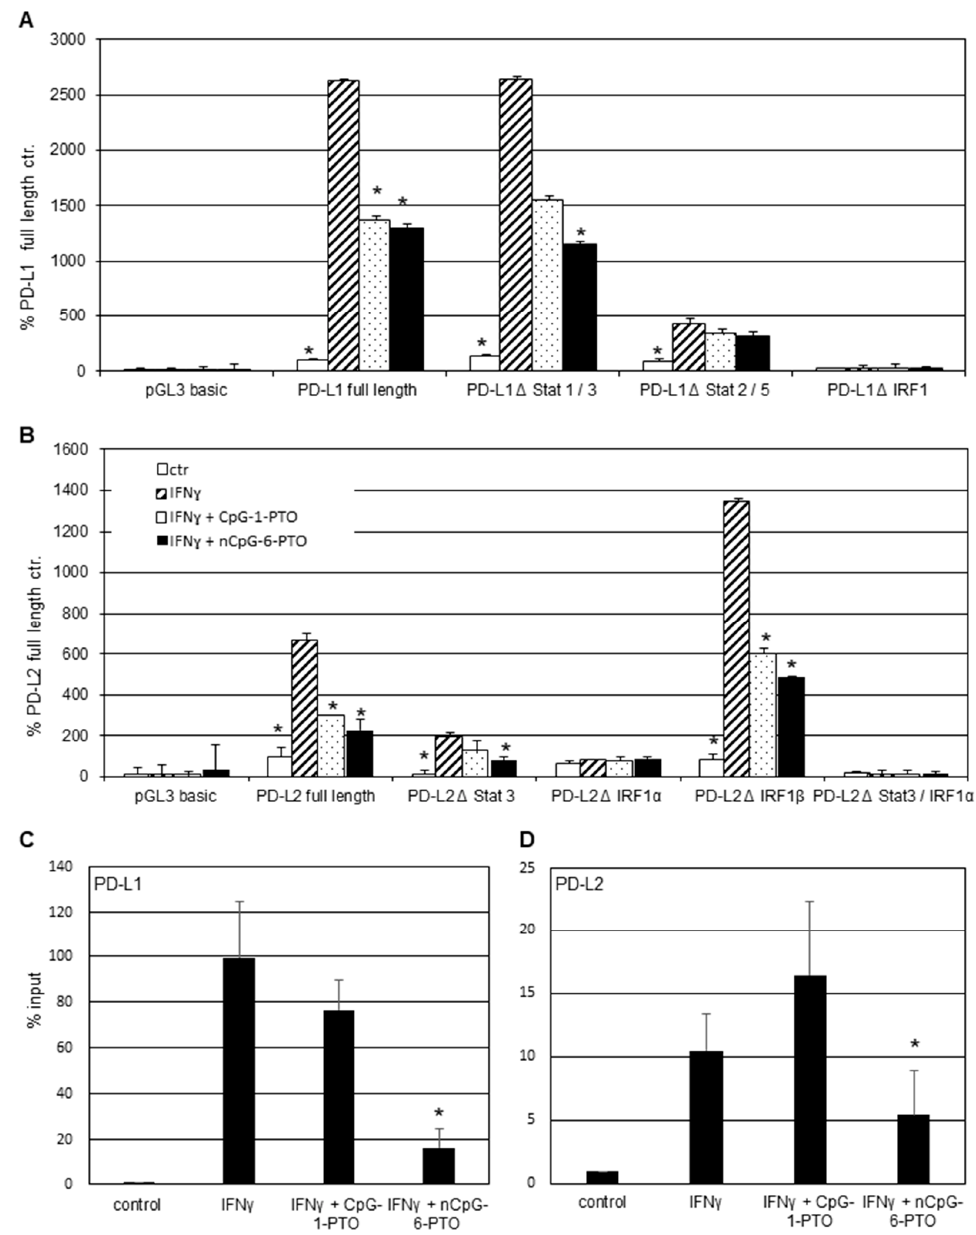
Figure 4. Promoter function analysis. Transient luciferase reporter assays for the ( A ) PD-L1 and ( B ) PD-L2 promoter. A375 melanoma cells were transfected with PD-L1 and PD-L2 promoter constructs including deletions of the relevant transcription binding sites. After stimulation with 20 ng/mL IFN γ for 1 h, cells were treated with 4 µ M CpG-1-PTO or nCpG-6-PTO for 16 h. ( C ) ChIP assay after pretreatment with 4 µ M CpG-1-PTO or nCpG-6-PTO for 1 h and consecutive IFN γ stimulation for 6 h using the IRF1 antibody for precipitation. PCR was performed with PD-L1 or ( D ) PD-L2 promoter specific primers. Each column represents the mean of 3 experiments. Statistical analysis was performed in relation to controls treated with IFN γ solely; * p < 0.05.